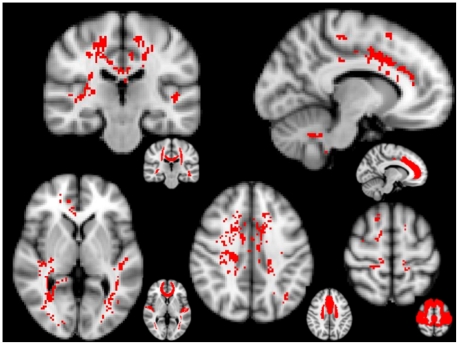
Brain voxelwise MTr comparison between RIS and RRMS.Red voxels show regions with significantly (p<0.05, cluster-corrected for multiple comparisons) lower MTr values in RRMS than in RIS. On smaller brains at the bottom right of each image, red shows the brain regions of the Harvard-Oxford GM atlas and DTI-based WM anatomy atlas corresponding to significant clusters. Background image is the MNI standard brain. Significant brain regions included the superior corona radiata, the body of corpus callosum and the inferior fronto-occipital fascicle (top-left image in coronal orientation); the paracingulate and cingulate gyri (top-right image in sagittal orientation); the inferior longitudinal fascicle, the planum temporale and the genu of corpus callosum (bottom-left image in axial orientation), the superior corona radiata and the paracingulate and cingulate gyri (bottom-center image in axial orientation); and the superior frontal, post- and precentral gyri (bottom-right image in axial orientation). See text for abbreviations.